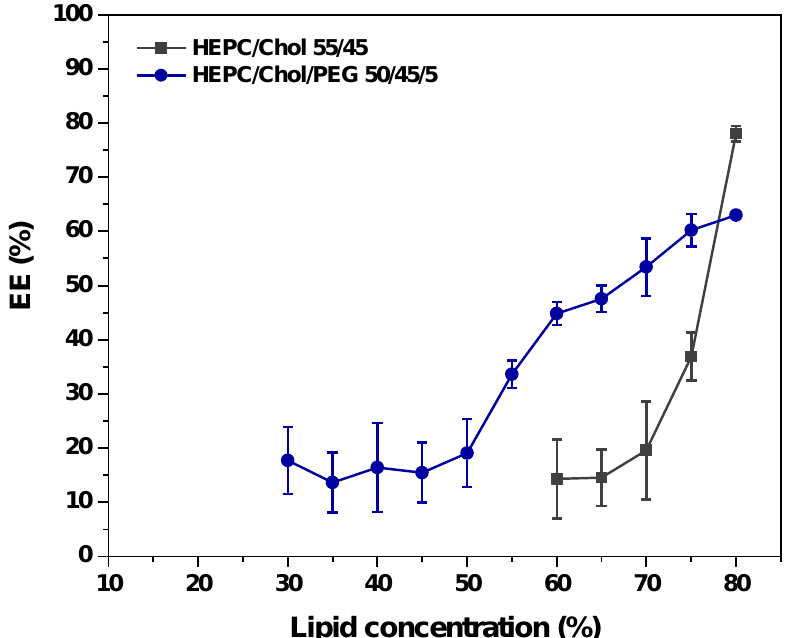
Figure 4. Uptake of calcein into calcein-free VPGs. The VPGs were prepared calcein-free with TRIS buffer (10 mM TRIS, 0.5 mM EDTA, pH 8.5) containing 100 mM NaCl by homogenization of the lipid film with the aqueous buffer by DC (2350 rpm, 30 min, and 20 ◦ C). In the next step, 60 mM calcein buffer was added to the VPGs and homogeneously dispersed by DC. For HEPC/Chol 55/45 up to a total lipid concentration of 40% with 1000 rpm, for 2 min, and at 20 ◦ C. For HEPC/Chol/PEG 50/45/5 up to 20% for VPGs with a lipid concentration lower than 55%, and up to 40% for VPGs with a lipid concentration of 55% and higher; with 600 rpm, for 2 min, and at 20 ◦ C. In the third step, the calcein/VPG mixtures were diluted with TRIS buffer by DC (500 rpm, 2 min, and 20 ◦ C). The amount of calcein, that was taken up into the liposome formed from the open membrane stacks structures, was determined by encapsulation efficiency (EE) measurements by time-resolved fluorescence as described in a previous study [2]. Data are shown as the mean ± SD (n =